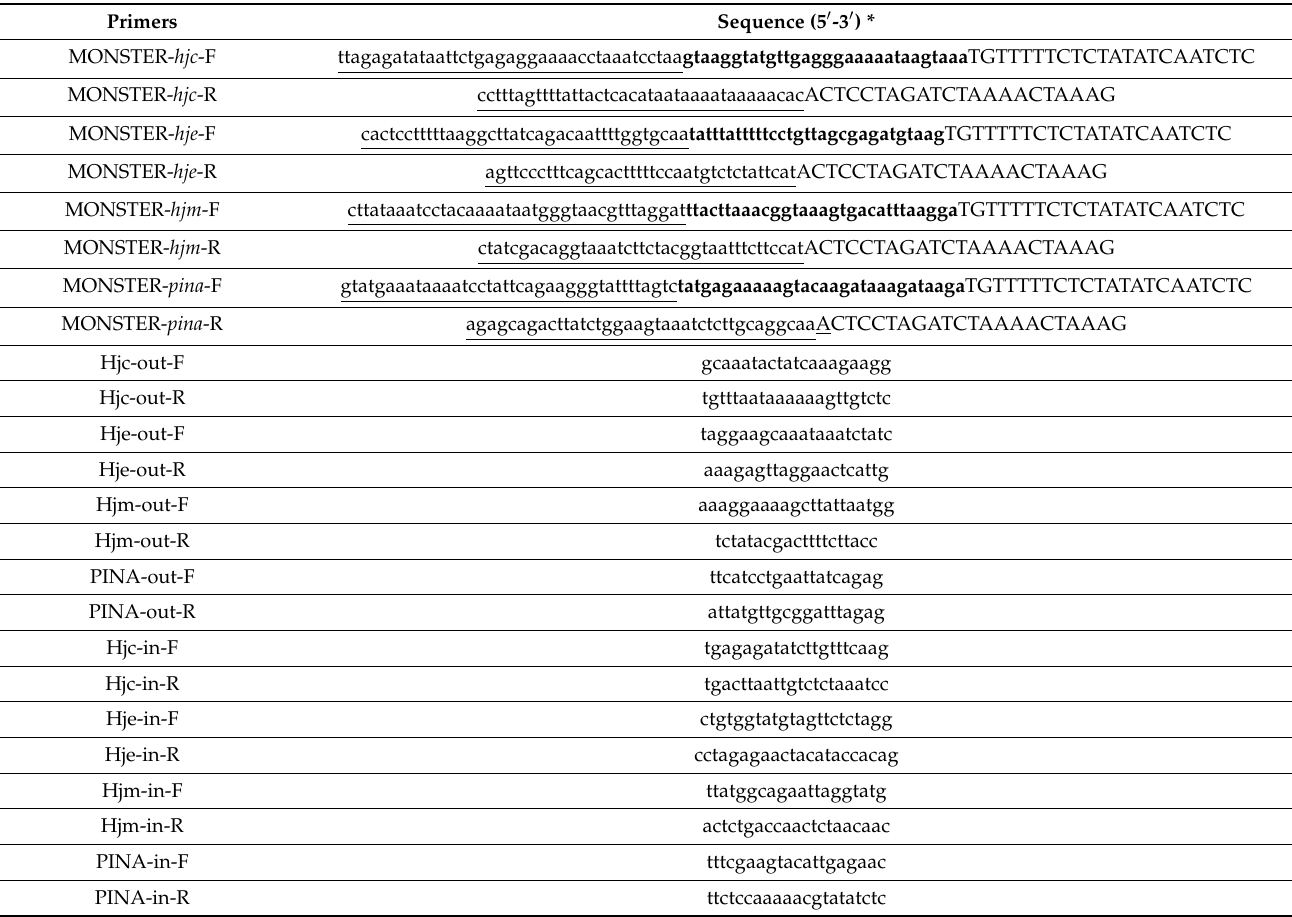
Table 2. Primers used in this